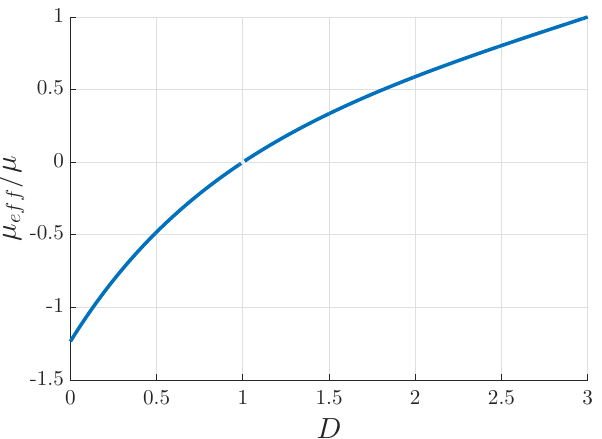
Figure 11. Plots of the effective viscosity defined by Equation (34) with respect to the mass dimen- sion D